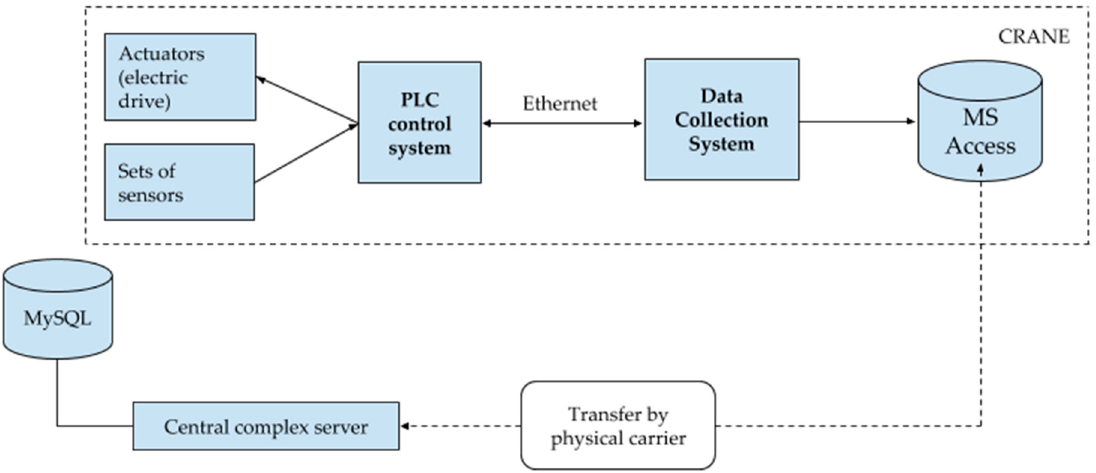
Figure 8. Structure of the DC system at crane complexes.